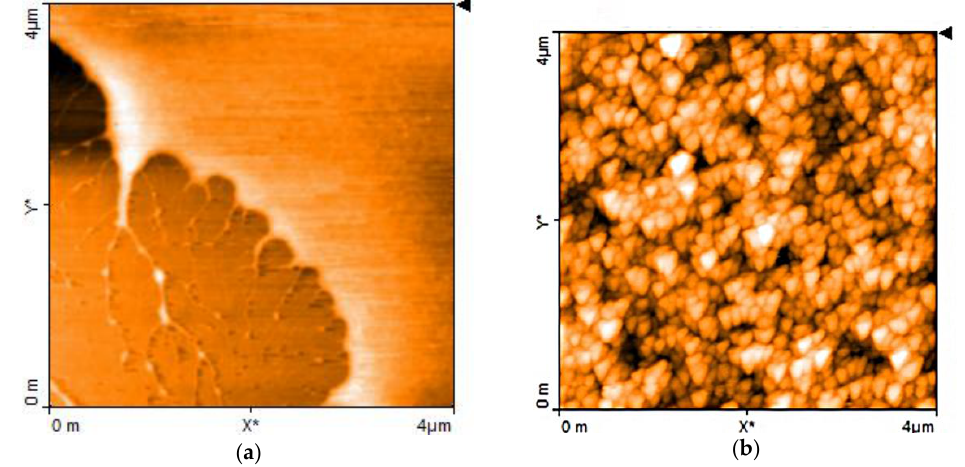
Figure 2. Atomic Force Microscopy (AFM) image close to the border of a thin film of chitosan-copper complex deposited onto a silicon substrate (visible in the bottom left portion) ( a ); AFM image of the chitosan:CuOx film( b ).